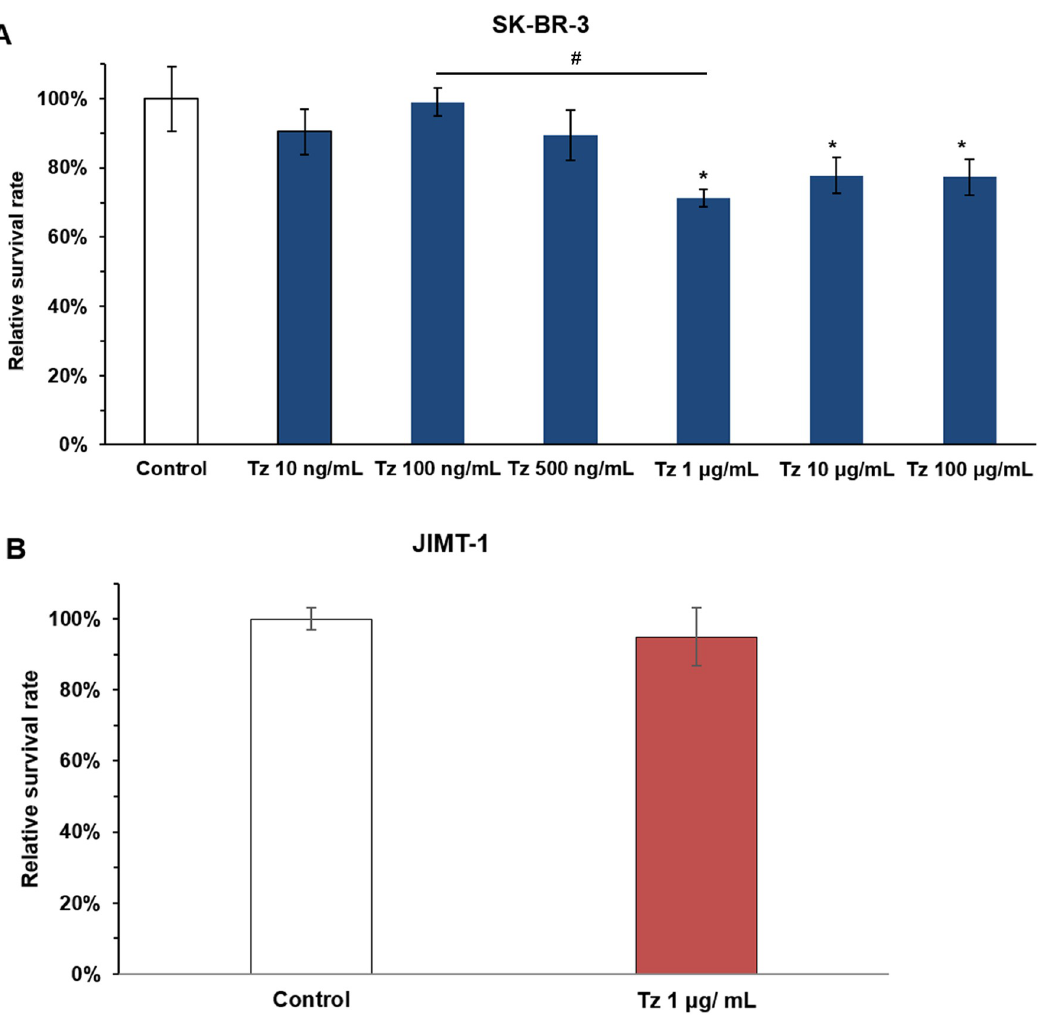
Fig 1. Cytotoxic effects of Tz on Tz-sensitive and -resistant breast cancer cells. (A) Response to Tz with dose increase in SK-BR-3 cell line. The optimal dose of Tz was established. (B) Resistance to Tz in JIMT-1 cell line. Cells were treated with distilled water (control) or Tz for 72 h. Viable cells were counted in a Neubauer chamber. Relative survival rates are shown as percentages of untreated control cells. Bars shows mean ± standard deviation of triplicates. One-way ANOVA followed by post Scheffe test was used for statistical analysis to compare between groups. ( � P < 0.05 significantly different from control; # P < 0.05 significantly different from 1 μ g/mL Tz treatment) Student’s t-test was used for statistical analysis to compare Tz treatment with control in JIMT-1 cell